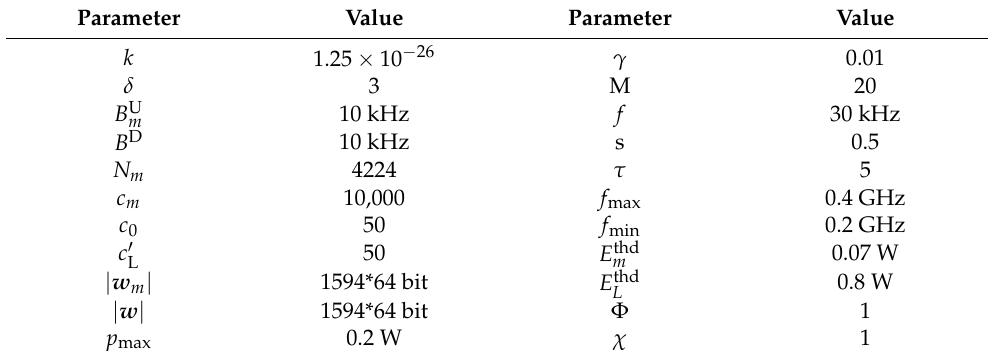
Table 1. Values of main parameters.